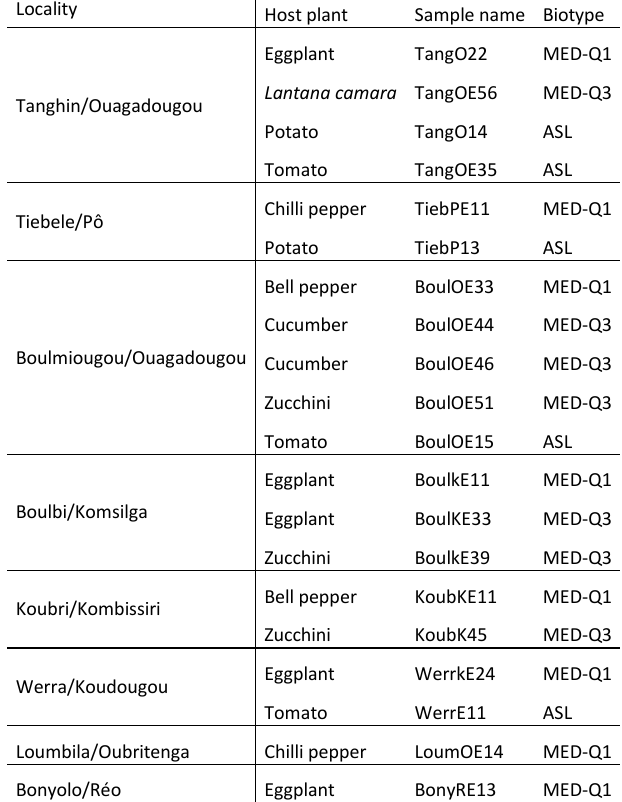
Table 1 . Samples used for the phylogenetic analyses of Ca. Hemipteriphilus asiaticus Locality Host plant Sample name